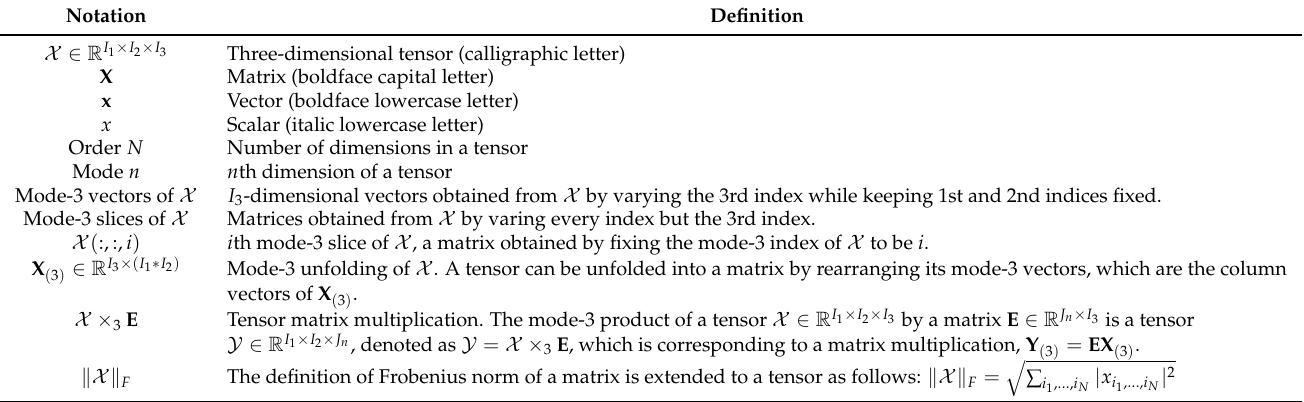
Table 1. Notations And